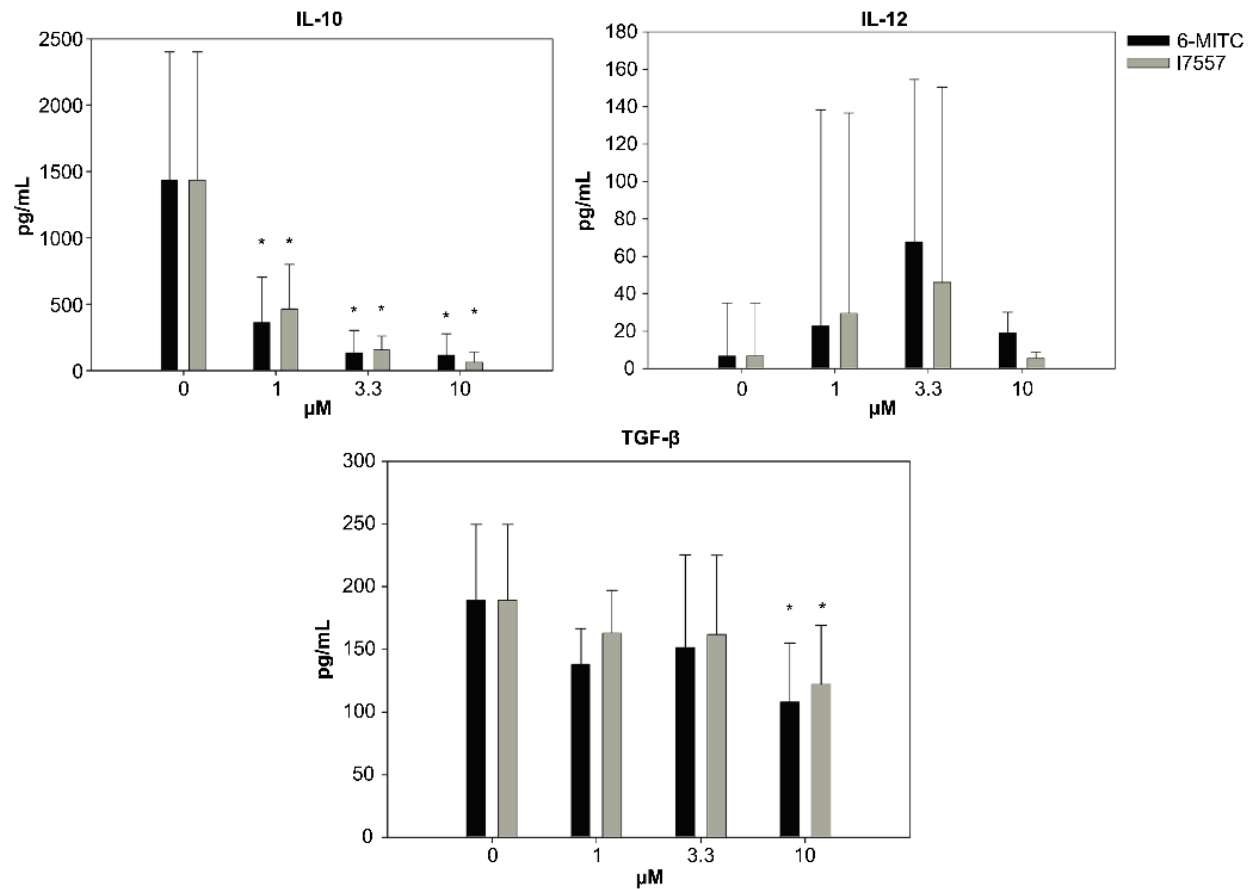
Figure 4. The secretion of IL-10 and TGF- β was inhibited by 6-MITC and I7557 in a dose-dependent manner. * p < 0.05 in comparison to control.